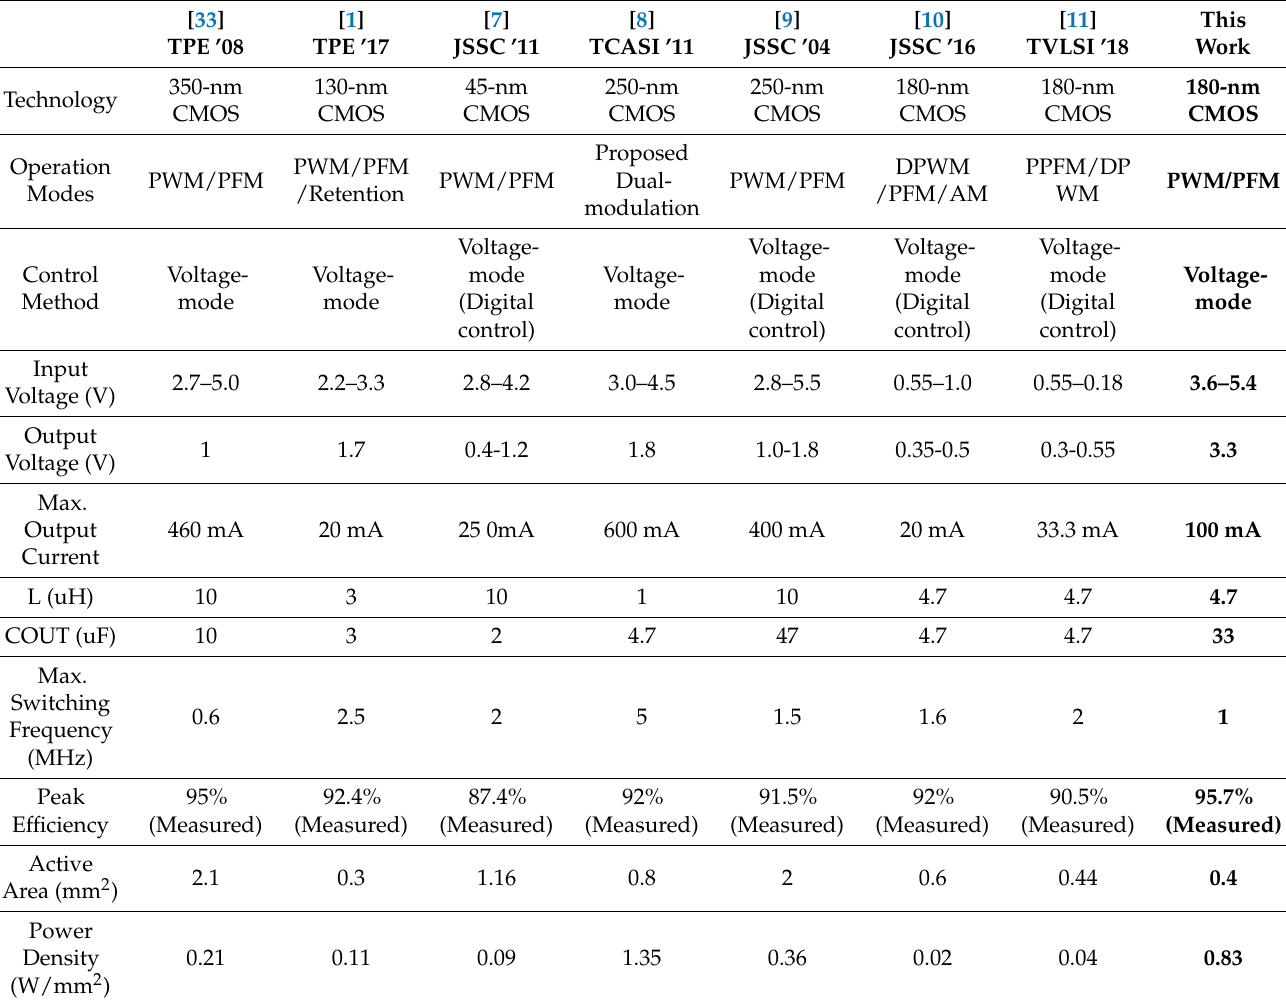
Figure 15. Measured efficiency of the proposed dual-mode buck converter over load current ( a ) for entire load conditions and ( b ) for light-load conditions. Table 1. Performance summary and comparison.